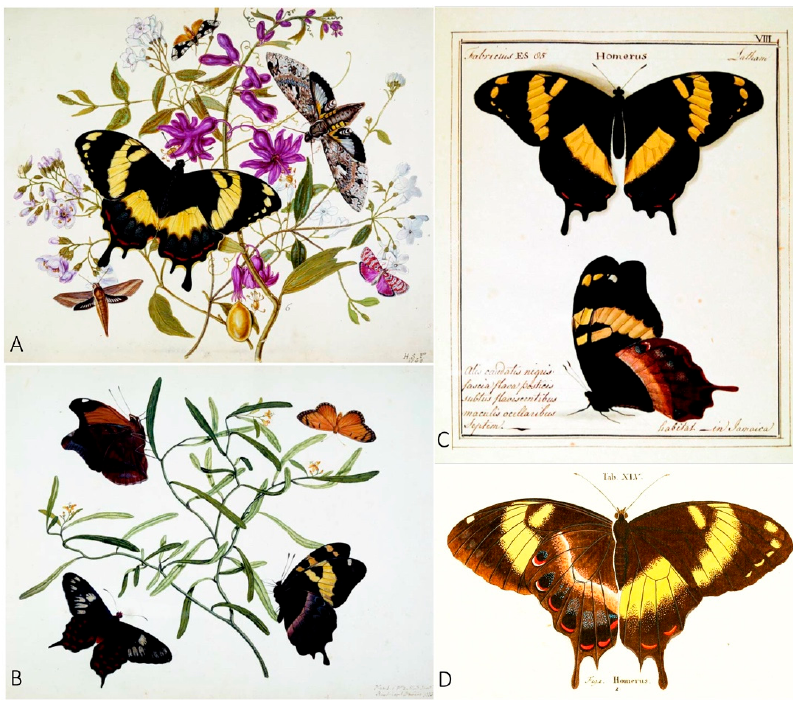
Figure 3. Paintings of Papilio homerus from the 18th century. Putative first two paintings of P.